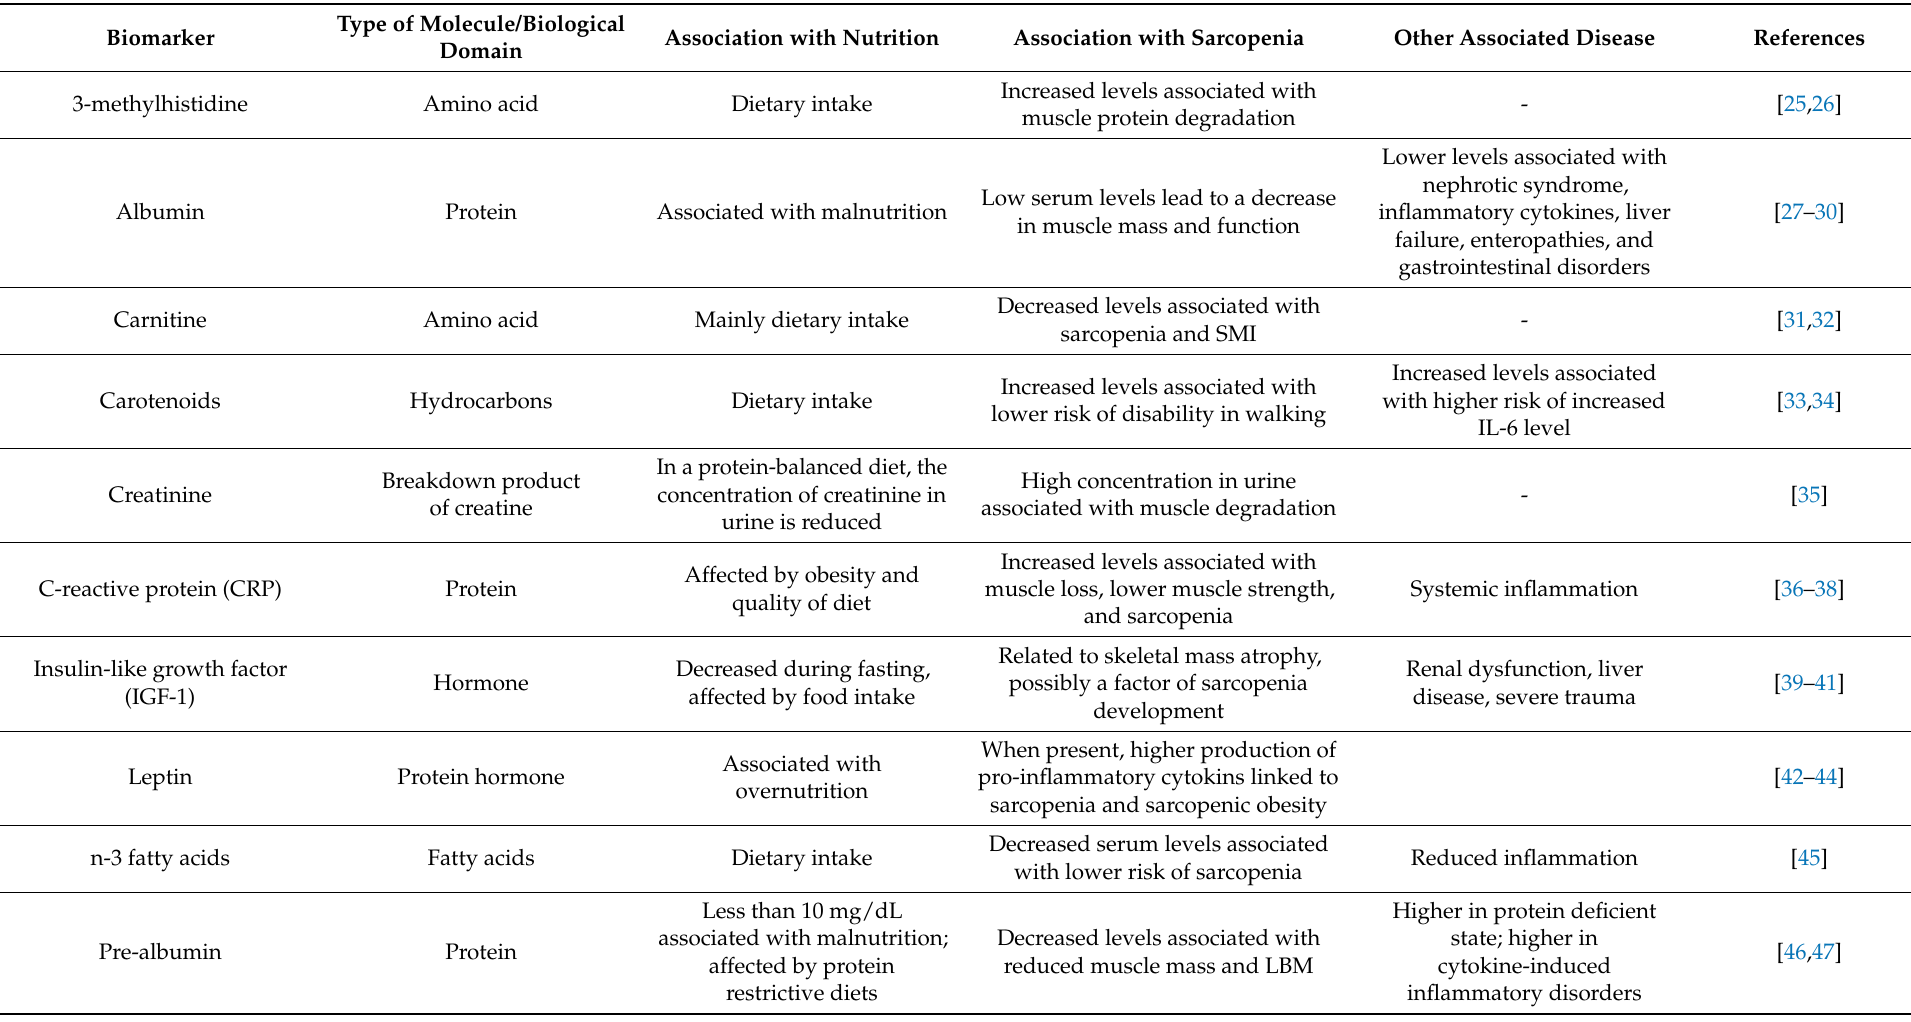
Table 1. Characteristics of biomarkers and their relation to sarcopenia and